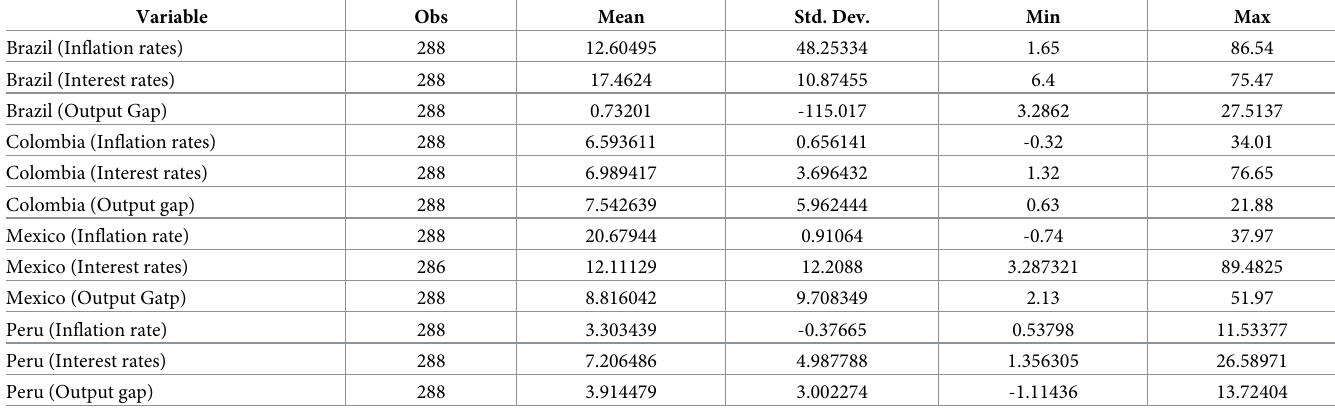
Table 2. Descriptive statistics (quarterly series, 1990q1 –